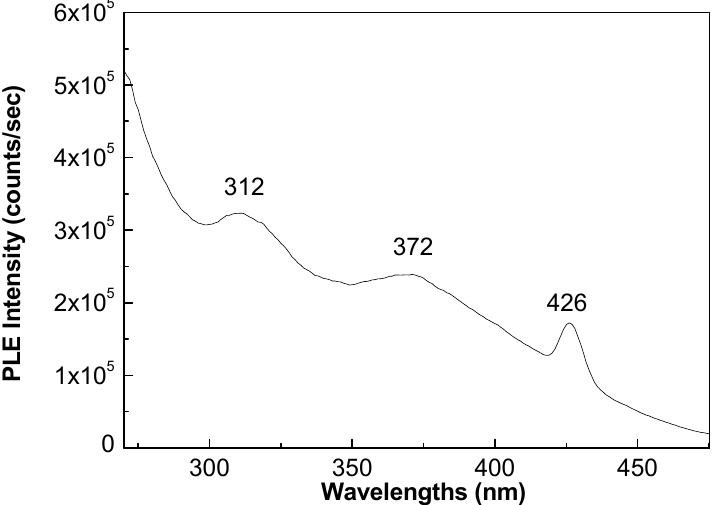
Figure 4. PLE spectrum of the MS recorded at the emission wavelength of 475 nm.